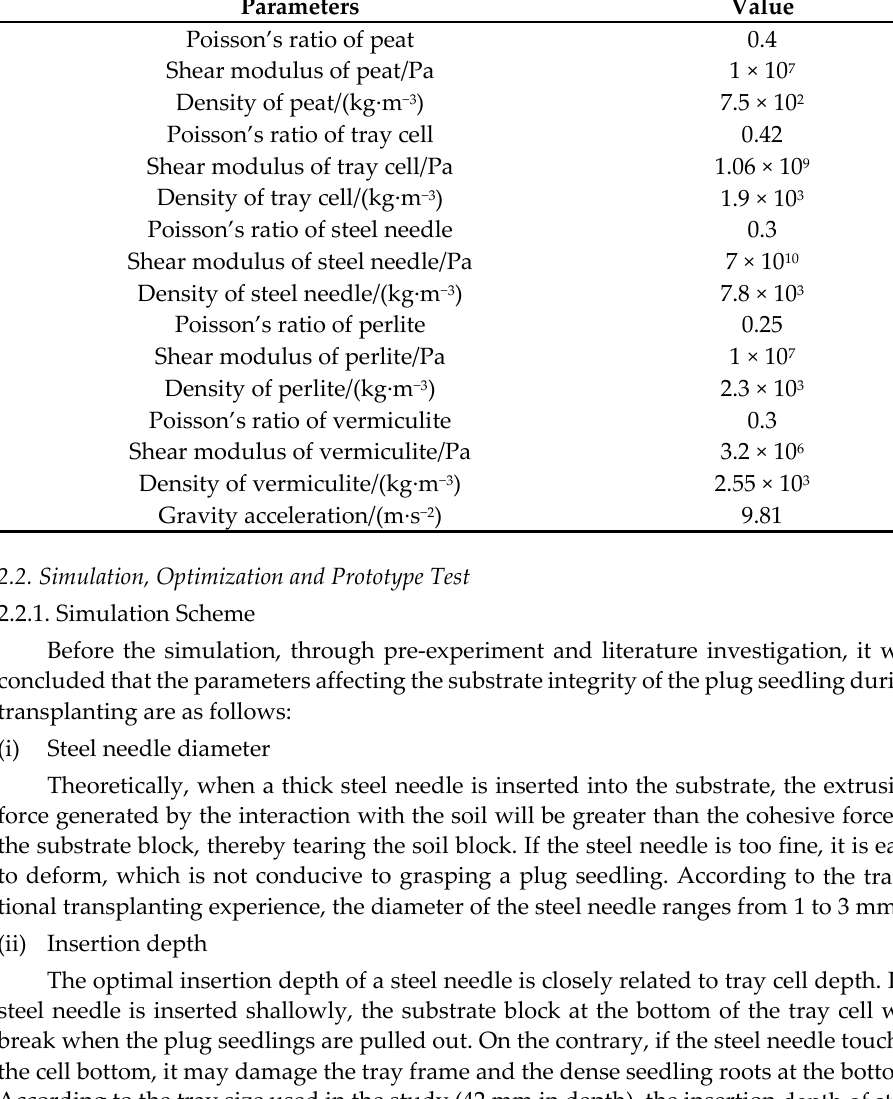
Table 1. Simulation parameters.